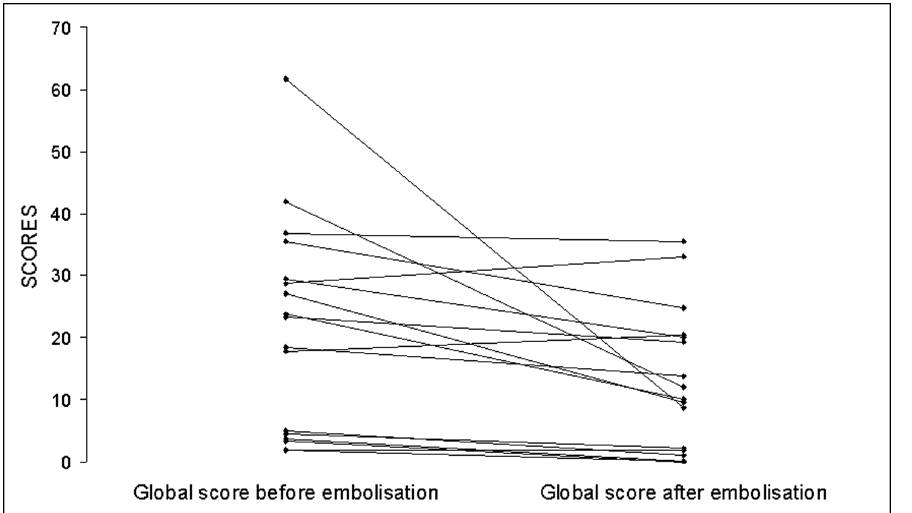
Figure 2. Global score of the Saint George’s Respiratory Questionnaire in 17 HHT patients before and 6–12 months after embolisation of